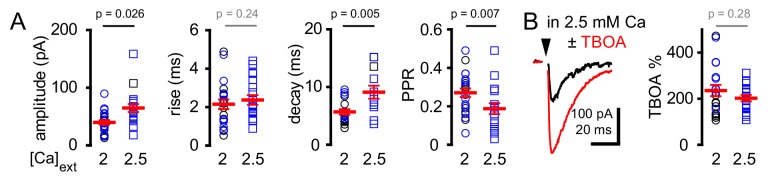
CF-GoC spillover EPSCs are sensitive to release probability.(A) Summary plots of peak amplitude (44 ± 6 pA and 74 ± 7 pA; n = 26 and 19), rise-time (2.1 ± 0.2 ms and 2.4 ± 0.3 ms; n = 22 and 19), decay-time (5.7 ± 0.5 ms and 9.1 ± 1.1 ms; n = 18 and 12), and PPR (0.27 ± 0.02 and 0.18 ± 0.03; n = 22 and 18) of CF-EPSCs in either 2 or 2.5 mM extracellular [Ca2+], respectively. (B) CF-EPSCs before and following glutamate uptake inhibition (TBOA, red). TBOA increased the peak amplitude and slowed the kinetics of EPSCs to a similar extent as in either 2 or 2.5 mM extracellular [Ca2+]. Summary of % TBOA (50 µM) peak amplitude increase in 2 or 2.5 mM (209 ± 23% and 178 ± 13%) extracellular [Ca2+] (n = 23 and 18). Black and blue symbols denote electrical and light stimulation, respectively. Circles represent individual experiments in 2 mM [Ca2+] and squares are measures in 2.5 mM [Ca2+].